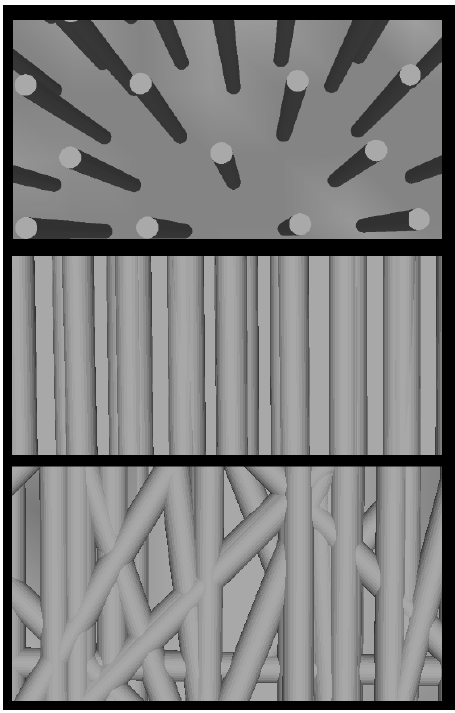
Figure 5. Upright/Straight/Random orientations of the hair (top view). Figure 5. Upright / Straight / Random orientations of the hair (top